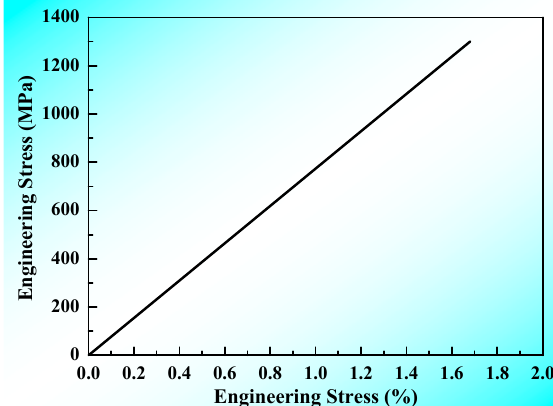
Figure 1. The schematic of samples and fatigue test mode.